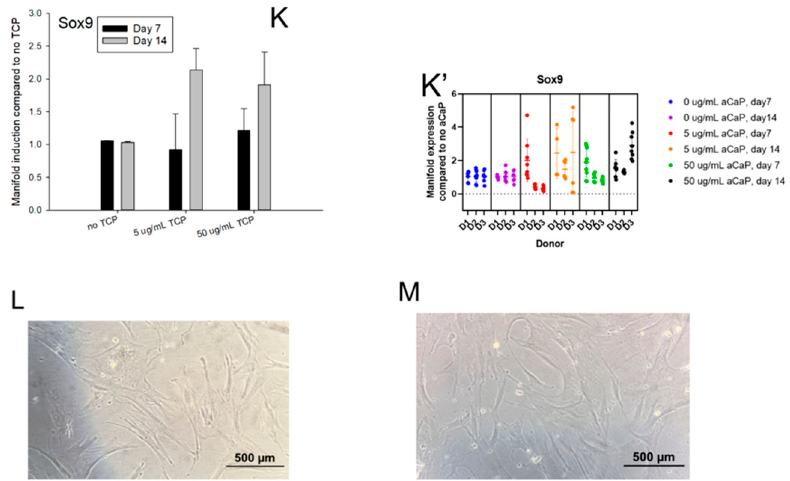
Figure 2. Average manifold induction of different genes averaged for three human donors ( A – K ) and corresponding nested plots for the three donors (D1, D2, and D2) with means and standard deviations for each donor ( A’ – K’ ). Representative images for 0 aCaP ( L ) and 50 µg/mL aCaP ( M ) after 14 days. Experiments were carried out for three conditions and two time points, with 0, 5, or 50 µg/mL aCaP nanoparticles (TCP = aCaP nanoparticles) and induction for 7 or 14 days in culture, respectively. Results are given as means, and error bars denote standard deviations. For gene expression in osteogenic culture medium, see Appendix A, Figure A1.